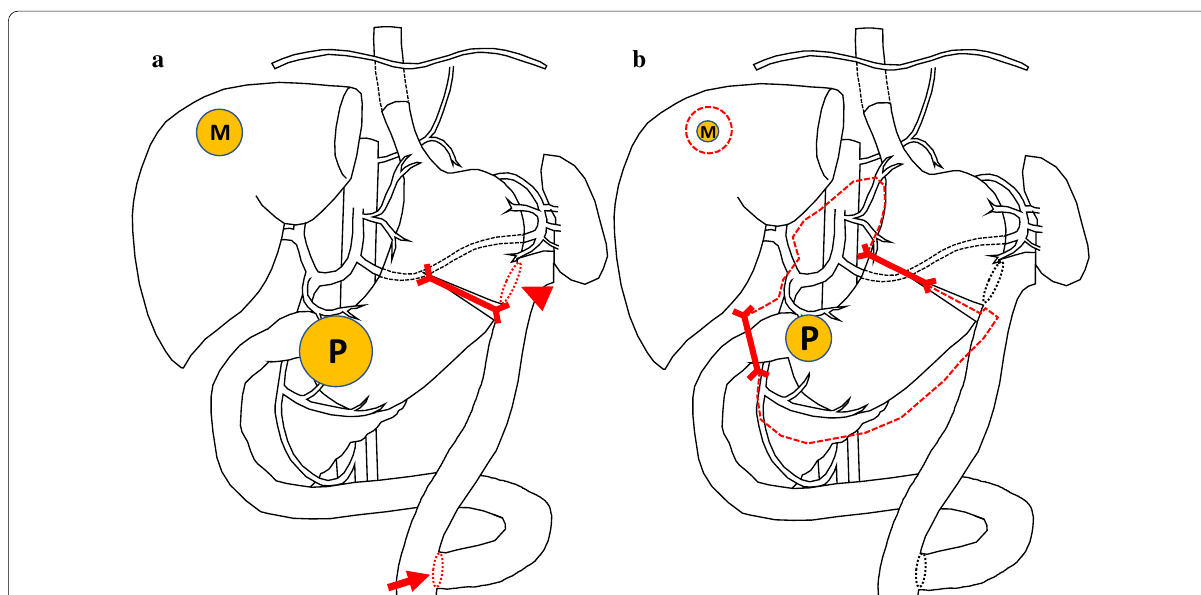
Fig. 2 Schema of each surgery. a First surgery; gastro-jejunal bypass (Roux-en-Y gastric bypass) and modified Devine exclusion were performed. Gastrojejunostomy (triangle) and jejuno-jejunostomy (arrow). b Second surgery; distal gastrectomy with D2 lymphadenectomy and partial hepatectomy were performed (red dotted line). P; primary lesion, M; metastatic lesion of the liver, and Red thick line; resection line of the stomach and